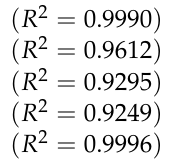
Figure 10. Typical failure mode of concrete under different strain rates ( a ) PC; ( b ) CNFC02.